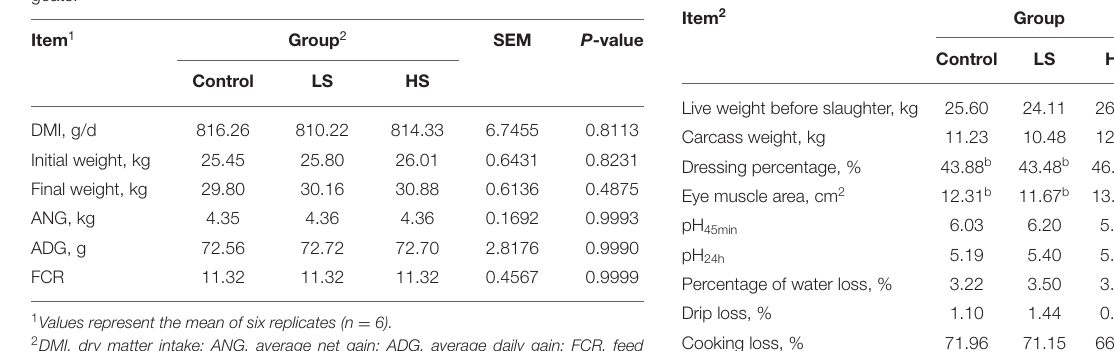
TABLE 5 | Effect of selenium-yeast on carcass traits of goats 1